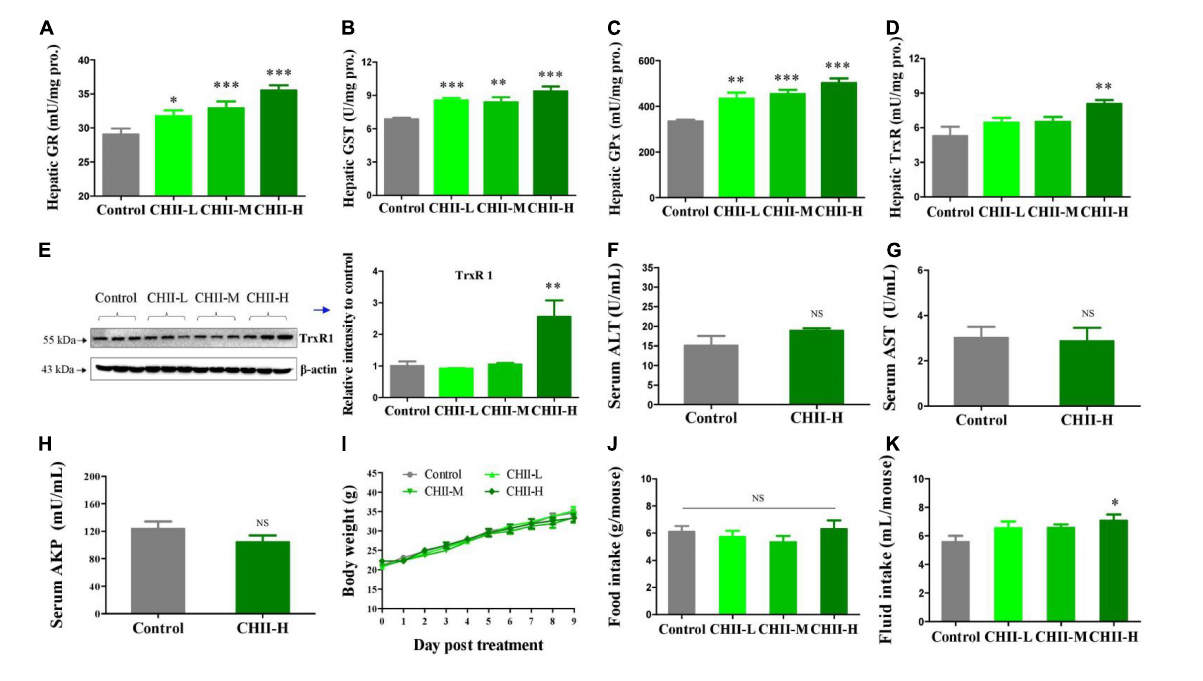
FIGURE1 Antioxidant capacity and safety of CHII (1/10, 1/20, 1/40, m/v) in mice. Treatments were introduced in animal experiment 1. (A–D) Enzyme activity levels of GR, GST, GPx, and TrxR in liver. (E) TrxR1 protein level in liver. (F–H) Levels of ALT, AST, and AKP in serum. (I–K) Body weight and food